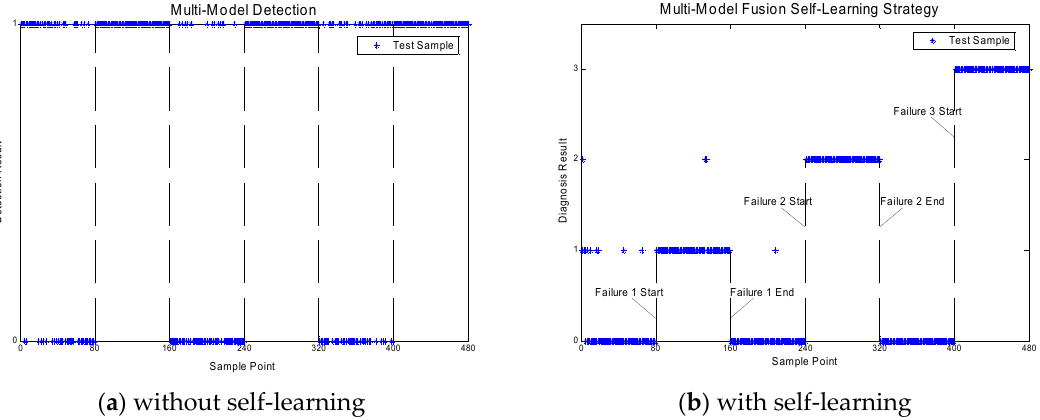
Figure 6. Fault detection with PCA-SVDD.